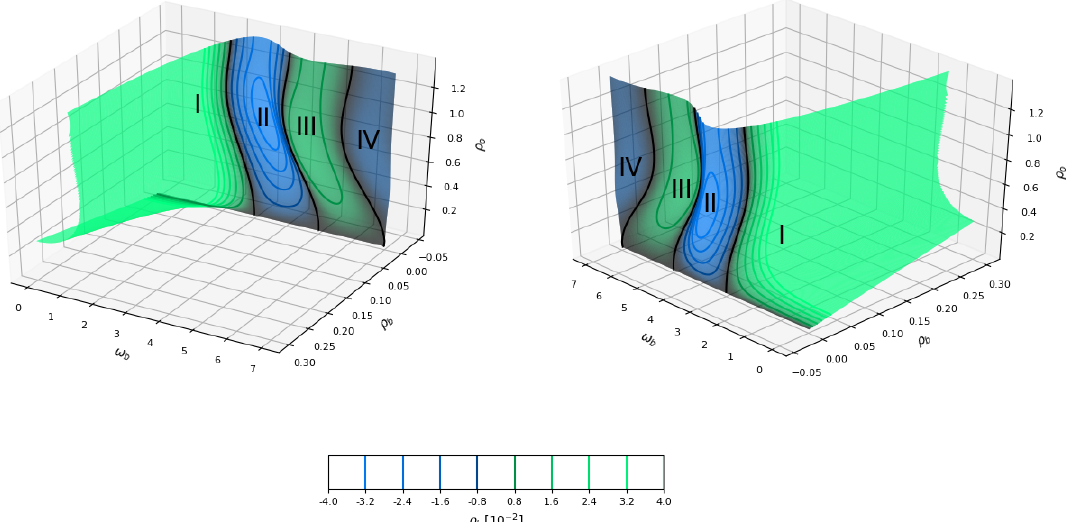
Figure 2 . The surface of static geometries corresponding to a periodically driven complex scalar (cid:12)eld. The surface intersects the boson star plane (cid:26) b = 0 at a set of curves as shown in the plot. In making this plot, we have adopted the phase convention that makes (cid:26) o a positive number (see (cid:12)gure 3). Hence the sign of (cid:26) b is nothing but the relative sgn( (cid:26) o =(cid:26) b ), which is correlated with the number of nodes of (cid:30) ( x ).